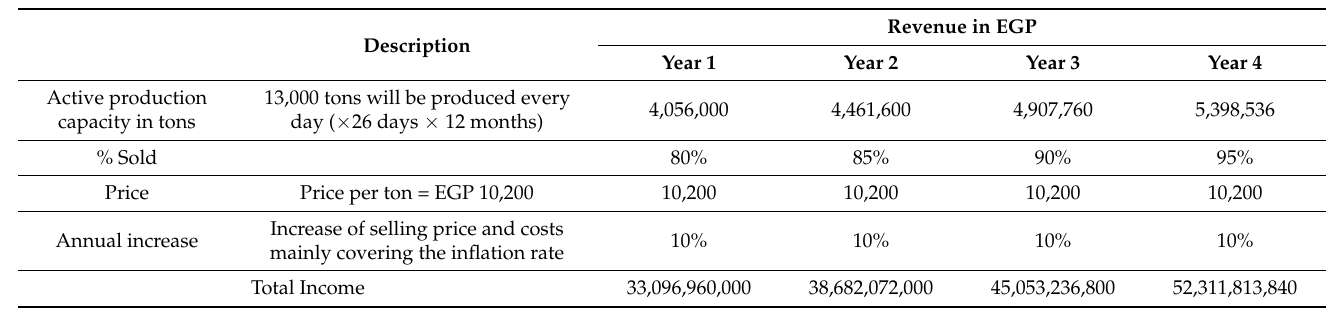
Table 7. Revenue projection.